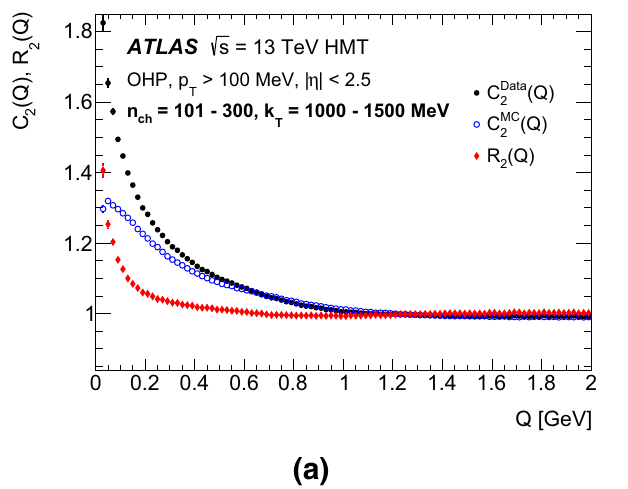
Fig. 1 Comparison of single-ratio two-particle correlation functions, ( Q ) and C MC ( Q ) , with the two-particle double-ratio correlation C data 2 2 function, R 2 ( Q ) , for the high-multiplicity track (HMT) events using a the opposite hemisphere (OHP) like-charge particles pairs refer-